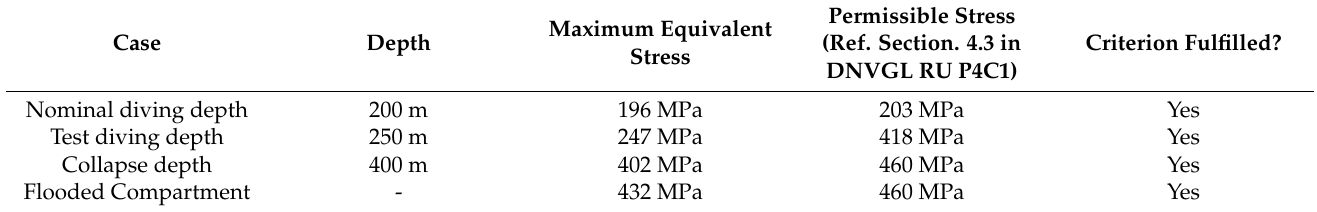
Table A6. Permissible and equivalent stresses in the external hull of the SFG baseline design.